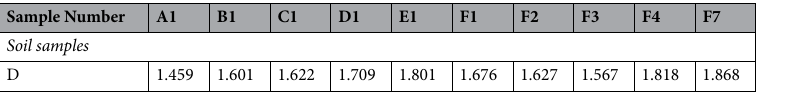
Table 5. The fractal dimension of soil samples. D is the fractal dimension. A1 is freeze–thaw cycle 0 times, water content 13%, dry density 1.48 g cm −3 .